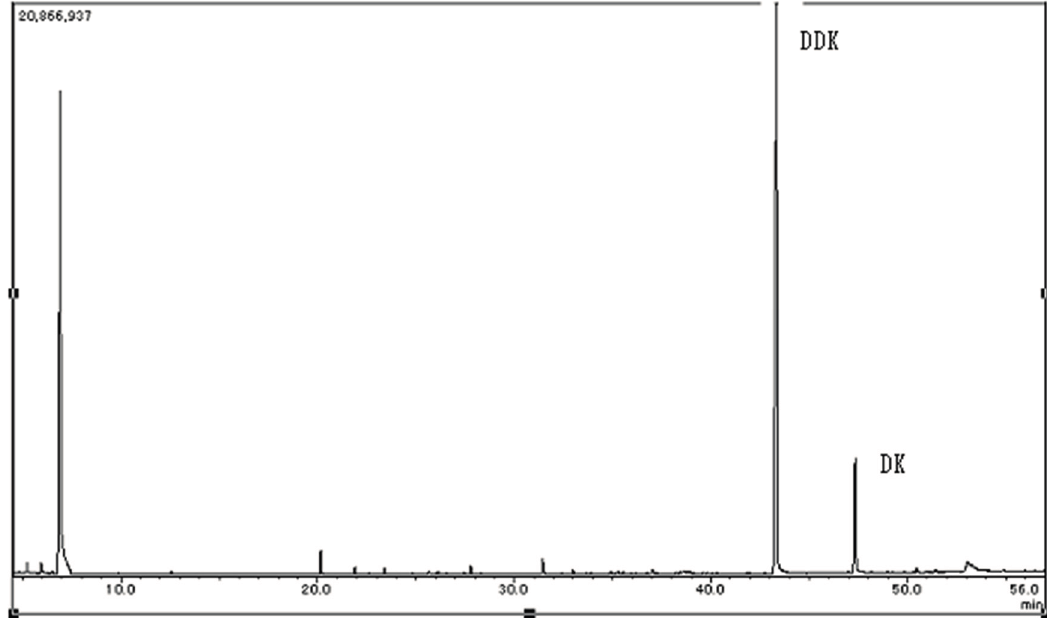
Figure 2. Detection of DDK and DK by GC-MS, obtained from hexane extract derived from leaves of Alpinia zerumbet